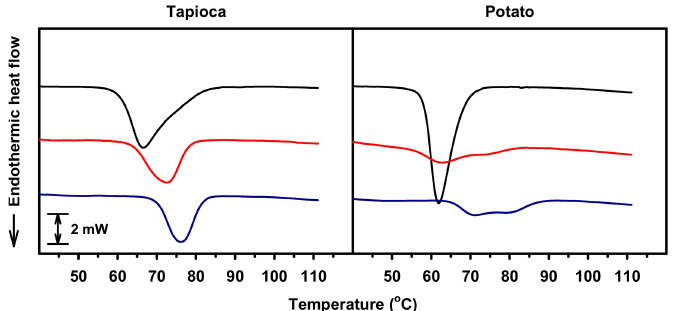
Figure 2. Gelatinization thermograms of native ( — ) and heat–moisture treated starches: 0-min holding time with 1 iteration ( — ) and 60-min holding time with 6 iterations ( — ).